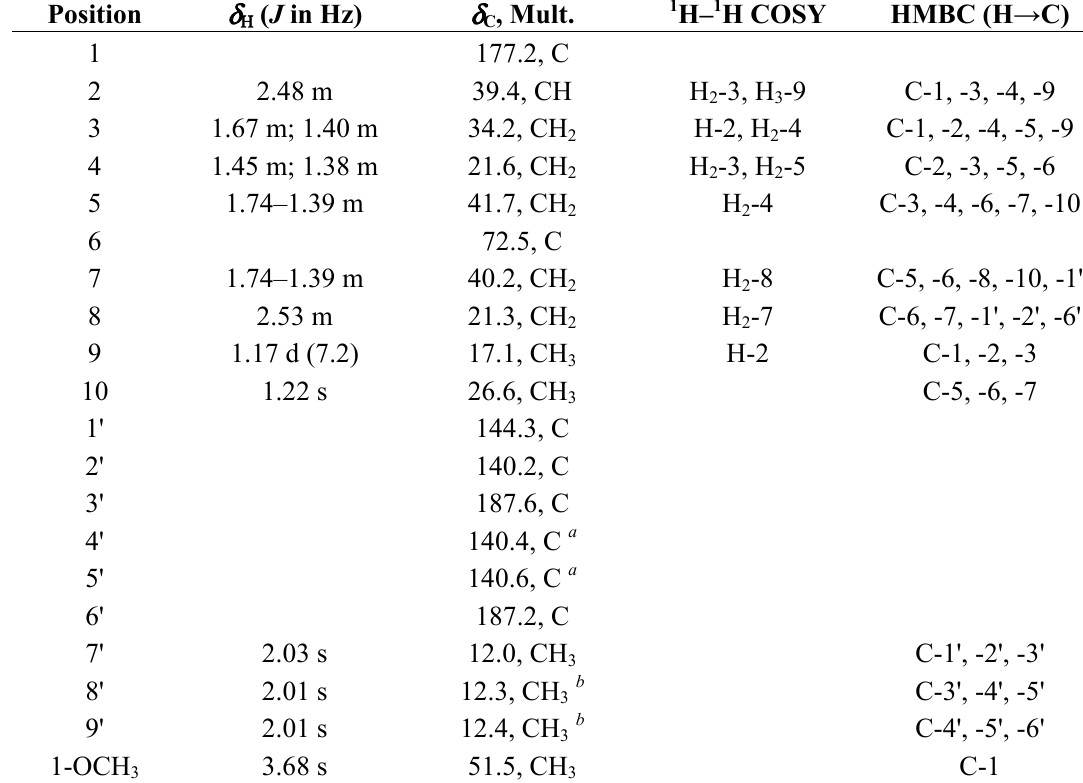
Table 1. 1 H- (400 MHz, CDCl HMBC correlations for quinone 1 .